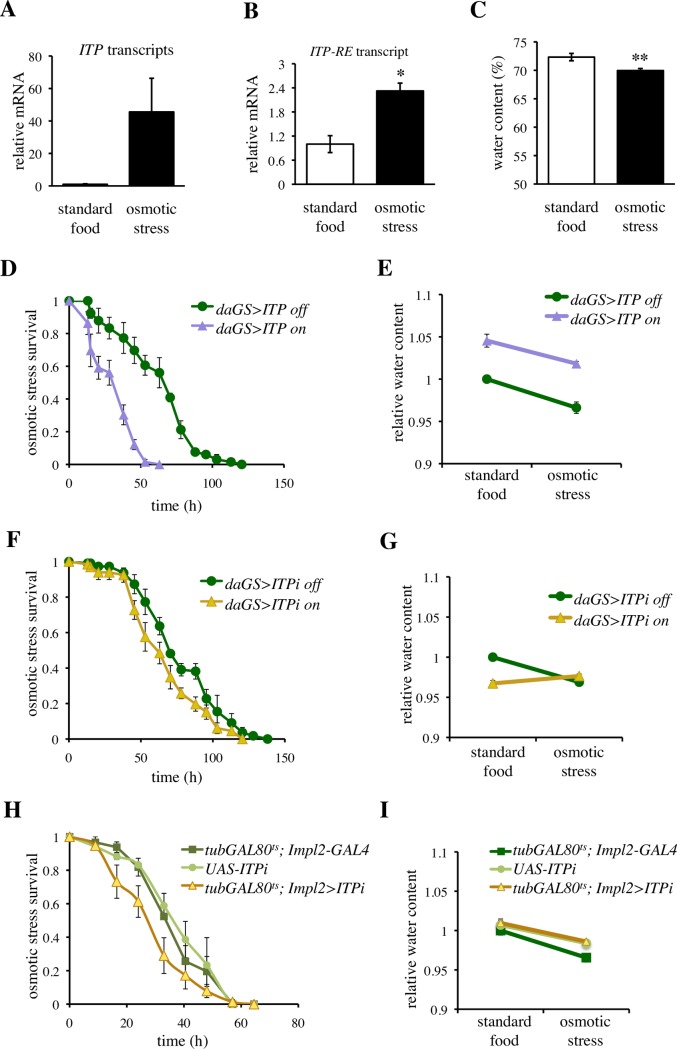
ITP regulates survival under osmotic stress.(A) Osmotic stress appears to increase expression of the ITP gene. However, when a primer pair that detects all 5 isoforms (transcripts RC, RD, RE, RF and RG, FlyBase FB2017_06) is used, a clear tendency is observed but the P value does not reach statistical significance. Two-tailed Student’s t–test: P > 0.05. (B) Osmotic stress increases abundance of the ITP RE transcript. A primer pair that detects solely this isoform was used. Two-tailed Student’s t–test: P < 0.05. (C) Osmotic stress decreases body fluid. Two-tailed Student’s t–test: P < 0.01. (D) Over-expression of ITP decreases survival during osmotic stress. Log-rank test: P < 0.001. Sample size: daGS>ITP off n = 66; daGS>ITP on = 66. (E) Over-expression of ITP increases body water, but does not affect the osmotic stress-induced loss of body water. Two-way ANOVA, ITP over-expression and osmotic treatment as fixed factors. Effect of ITP: P < 0.001, effect of osmotic stress: P < 0.001, effect of ITP × osmotic stress interaction: P > 0.05. See S1 Table for further details. (F) daGS-driven ITP RNAi (ITPi) decreases resistance to osmotic stress. Log-rank test: P < 0.05. Sample size: daGS>ITPi off n = 66; daGS>ITPi on n = 66. (G) daGS-driven ITPi decreases water content under standard conditions (two-tailed Student’s t–test: P < 0.001), and interacts with the effect of osmotic stress. Two-way ANOVA, ITPi and osmotic treatment as fixed factors; effect of ITPi: P < 0.01, effect of osmotic stress: P < 0.05, effect of the interaction: P < 0.001. See S2 Table for further details. (H) ITPi driven by the Impl2-based TARGET decreases osmotic stress resistance. Log-rank test: P < 0.01 for each comparison with controls. Sample size: tub-GAL80ts; Impl2-GAL4 n = 69; ITPi n = 66; tub-GAL80ts; Impl2>ITPi n = 75. (I) ITPi driven by the Impl2-based TARGET does not affect water content under standard conditions (two-tailed Student’s t–test: P > 0.05 for each comparison with controls), nor interacts with the effect of osmotic stress (two-way ANOVA, ITPi and osmotic treatment as fixed factors; effect of the interaction: P > 0.05. See S3 Table for further details. Thus, the Impl2-based TARGET enables disentangling the requirement for ITP under osmotic stress from its requirement for water preservation.